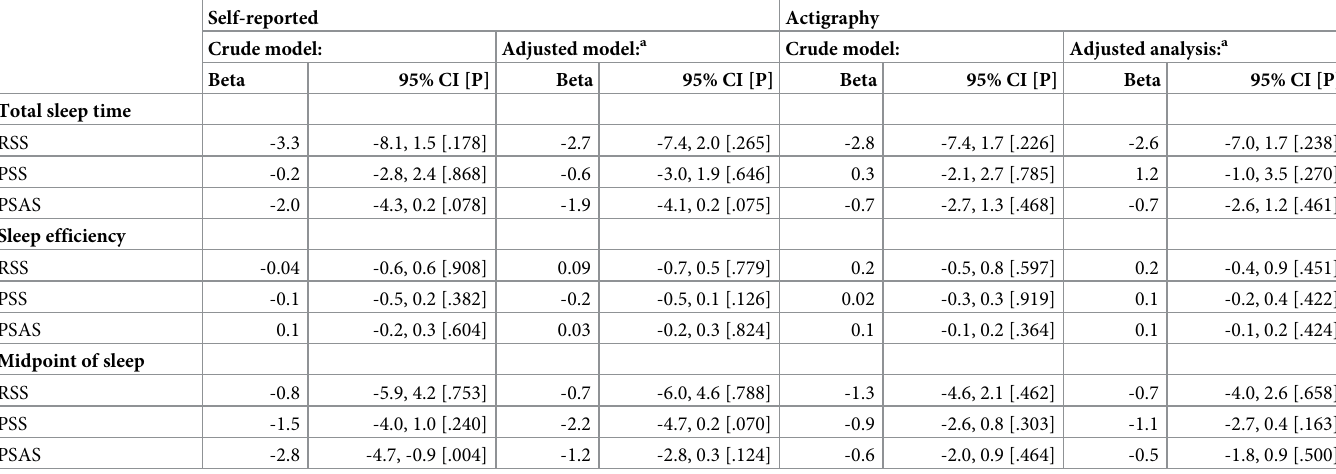
calendar month. Self-reported data TST and midpoint of sleep showed a different pattern over the days for the two groups (p for interaction < .001), but not in SE. For actigraph data, SE showed a different between the groups (p for interaction .027), but daily change in TST, mid- point of sleep and total white light showed a similar pattern in the two groups. Table 3 displays the association between the exposures RSS, PSS, PSAS and the outcomes TST, SE and midpoint of sleep, in pregnant women, analyzed by linear mixed model. When using self-reported data, an association between PSAS and midpoint of sleep was only detected Table 3. Association between sleep and different types of perceived stressors in pregnant women. Self-reported